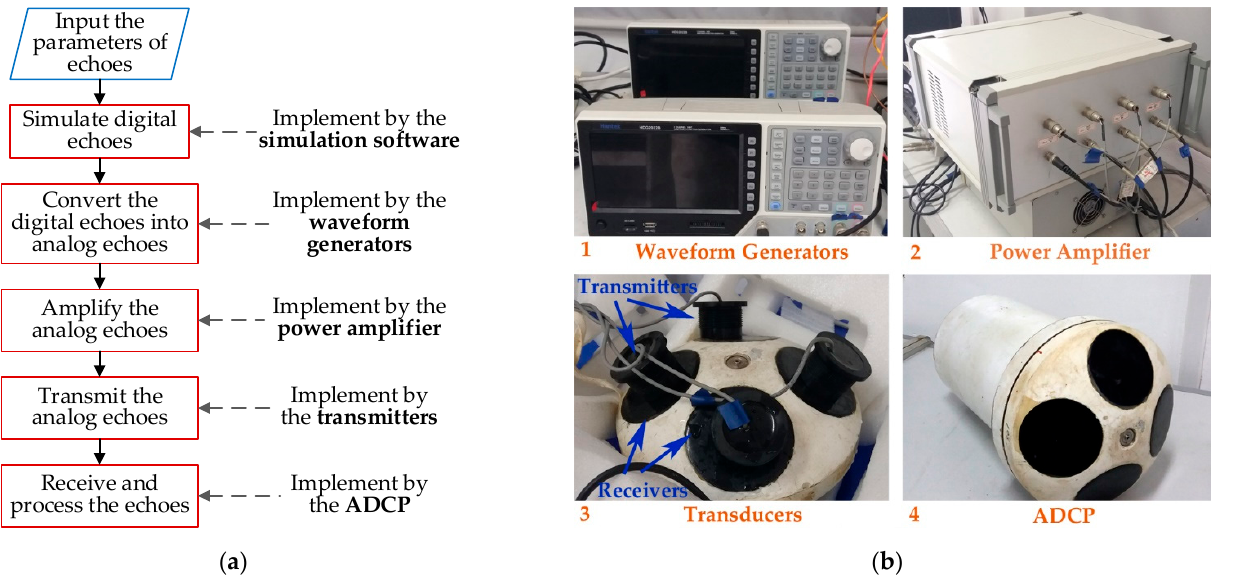
Figure 7. The experimental platform based on an onshore calibration system for ADCP: ( a ) workflow chart of the platform; ( b ) photos of the platform components.